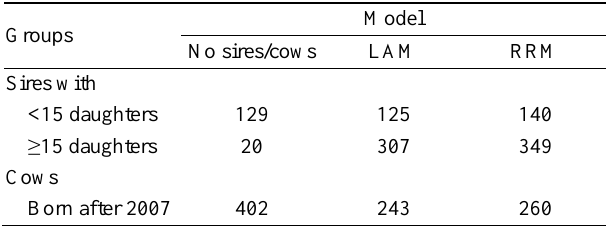
Table 4. Standard deviations of estimated breeding values (EBVs) from lactation average model (LAM) and random regression test- day model (RRM) for group of sires and cows Groups